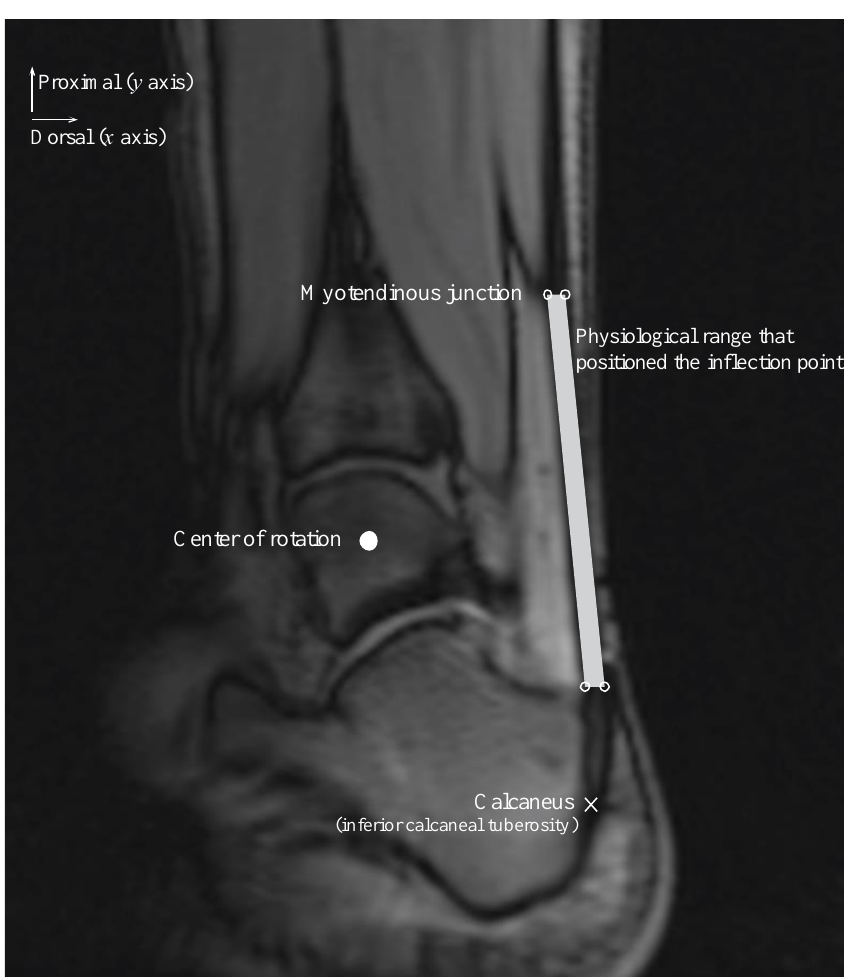
Figure 2. Representation of the physiological range of the inflection point within the Achilles tendon where the gain AT is calculated. The positions of the start (i.e., myotendinous junction) and end (i.e., inferior calcaneal tuberosity) points of the Achilles tendon, and ankle center of rotation are shown in a typical sagittal-plane MR image from one subject. The ankle angle was set at approximately –10° (ankle dorsiflexed position). The physiological range of the inflection point is defined as the area within the Achilles tendon and is represented as the area (gray color) of a quadrilateral comprising four vertices (points; indicated by white circle symbols).